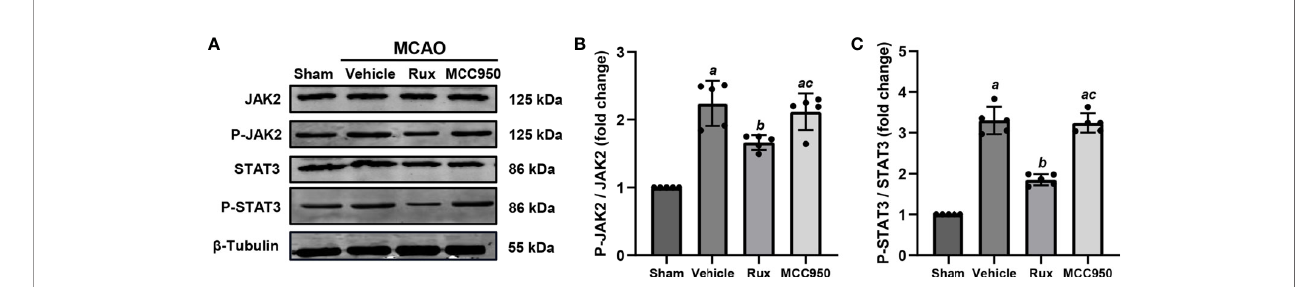
FIGURE 8 | The administration of Rux inhibited the activation of P-JAK2 and P-STAT3 3 days after MCAO. (A) Representative western blots showing that Rux inhibited P-JAK2/P-STAT3 expression in the peri-ischemic region 3 days after MCAO. (B, C) Quanti fi cation of P-JAK2/P-STAT3 expression in the ischemic penumbra. Means ± SD, n = 5/group. a P < 0.01 versus sham; b P < 0.05 versus vehicle; c P < 0.05